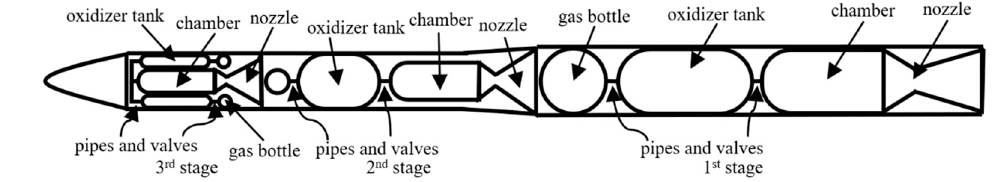
Figure 9. Structure in detail of LV powered by three stages of